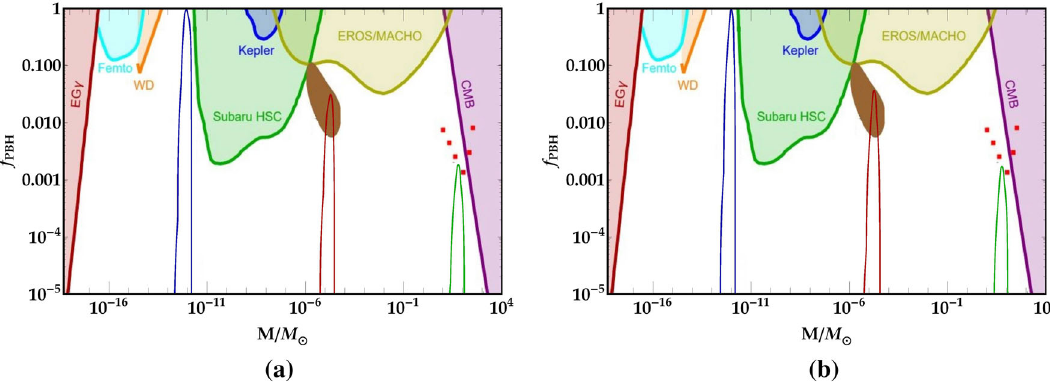
Fig. 6 a The PBH abundance f PBH versus the mass M in the quartic inflationmodelforthecases A H (blueline), B H (redline),and C H (green line). b Sameas a butinthenaturalinflationmodelforthecases A N (blue line), B N (red line), and C N (green line). The observational constraints on PBH abundance are shown by the shaded areas. The brown shaded area illustrates the allowed region of PBH abundance in the OGLE data [16]. The red dots show the upper bound on the PBH abundance due